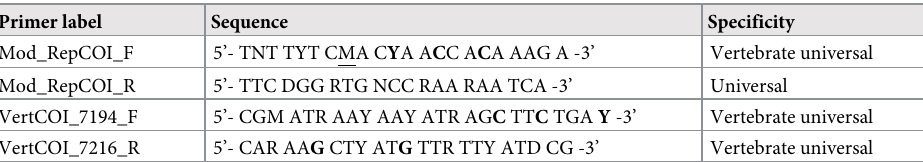
Table 1. Primer sequences used in this study. Primer